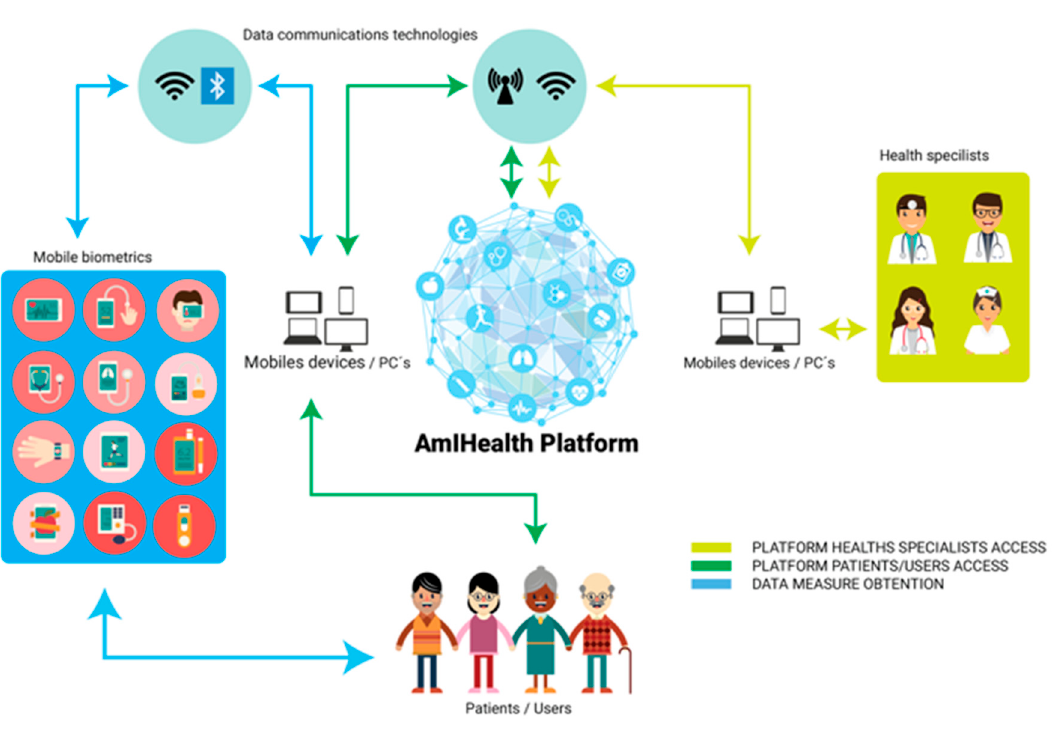
Figure 2. AmIHEALTH platform for blood pressure control